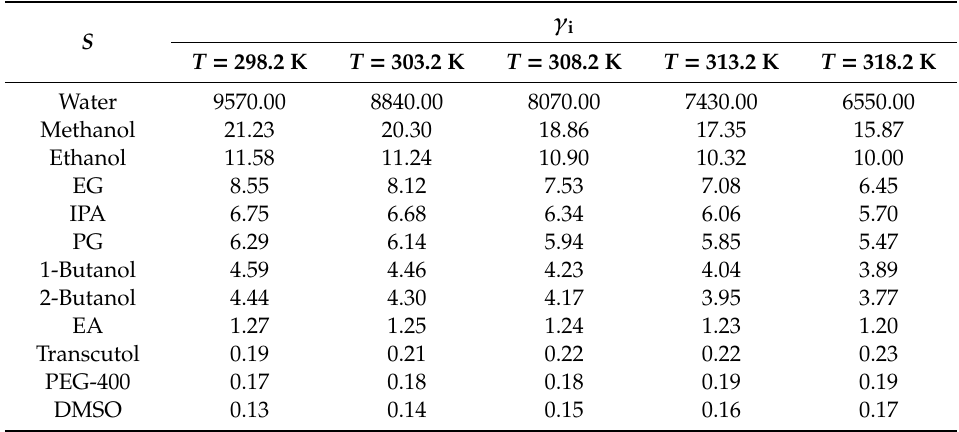
Table 2. The values of γ i for PPD in various neat solvents ( S ) at “ T = 298.2 K to 318.2 K” calculated using x idl and x e